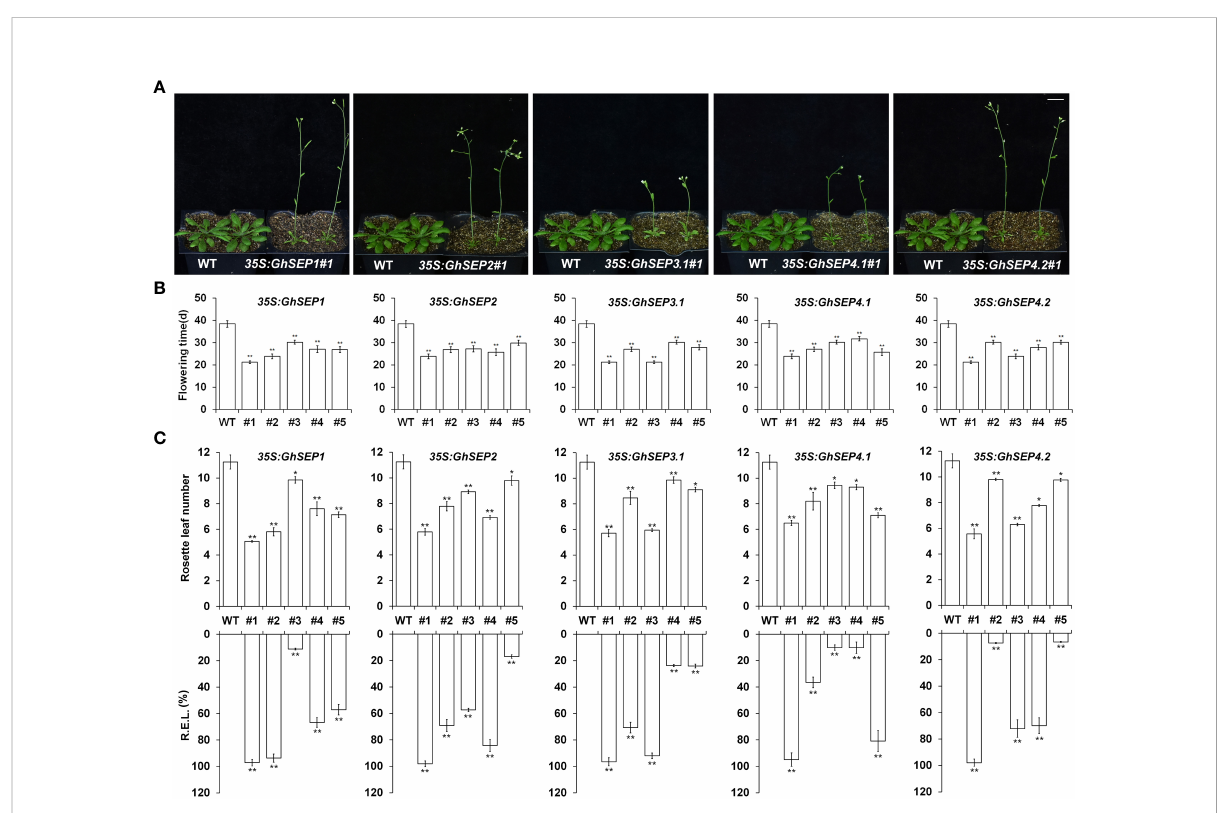
FIGURE 3 Phenotypes of 35S:GhSEP s transgenic Arabidopsis plants. (A, B) 35S:GhSEP s fl owered earlier than wild-type (WT) plants under the long-day (LD) conditions. The same WT plants served as the controls of the transgenic plants for taking photos in A. Scale bar stands for 1 cm. (C) Upregulation of GhSEP s in independent 35S:GhSEP transgenic plants is related to the degree of early fl owering under LD conditions. Asterisks indicate signi fi cant differences (Student ’ s t -test, * p ≤ 0.05, ** p ≤ 0.01). Error bars denote